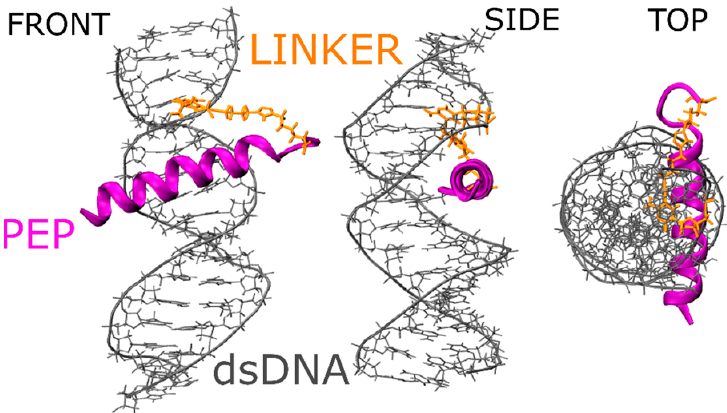
Figure 1. Front, side and top views of the DNA-peptide conjugate in double-stranded DNA form after click chemistry reaction; purple—peptide in α -helix conformation, gray—dsDNA in B-DNA form and orange—azide-alkyne Huisgen cycloaddition